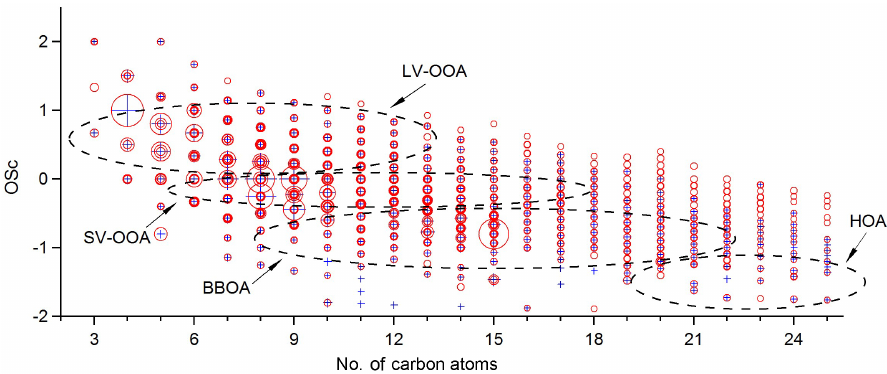
Figure 7. Overlaid carbon oxidation state (OS C ) plots for CHO subgroups in the samples from the periods with low (blue markers) and very high (red markers) incidents of fires. The marker areas reflect relative ion abundance in the sample. The area marked as SV-OOA, LV-OOA, BBOA and HOA correspond to the molecules associated with semivolatile and low-volatility oxidised organic aerosol, biomass burning organic aerosol and hydrocarbon-like organic aerosol as outlined by Kroll et al. (2011).